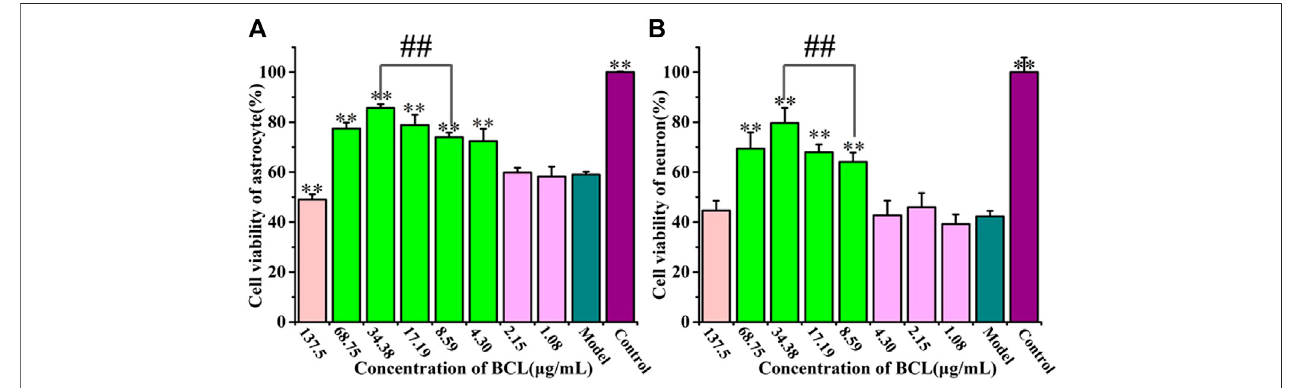
FIGURE4| ProtectiveeffectsofbaicalinonastrocytesandneuronsafterOGD/R. (A) CellviabilitycountsindicatingtheprotectiveeffectsofBCLonastrocytesafter OGD/R. (B) CellviabilitycountsshowingtheprotectiveeffectsofBCLonneuronsafterOGD/R.** p < 0.01,vs.themodelgroup;## p < 0.01,34.38 μ g/mlvs.8.59 μ g/ml.